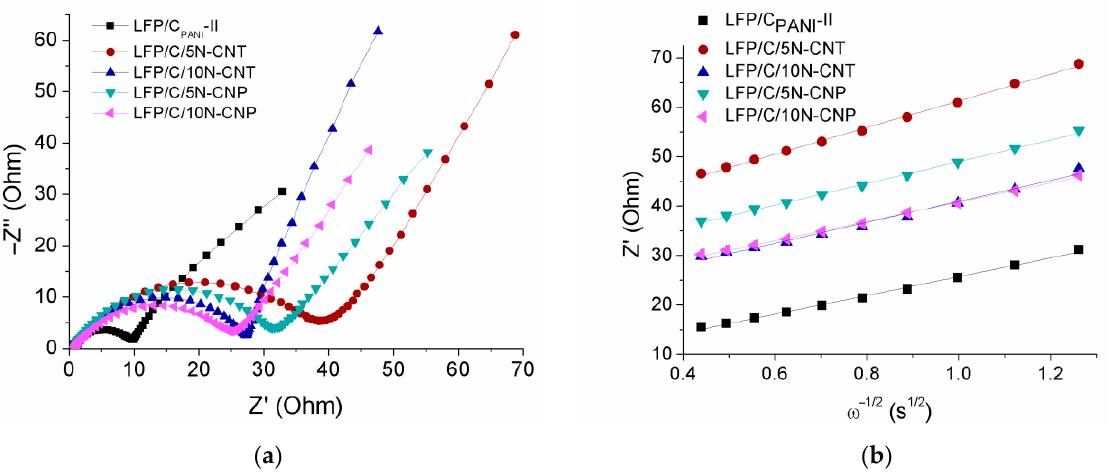
Figure 9. Electrochemical impedance spectroscopy data: the Nyquist plots ( a ) and the fitting plots of Z’ vs. ω – 1/2 ( b ).